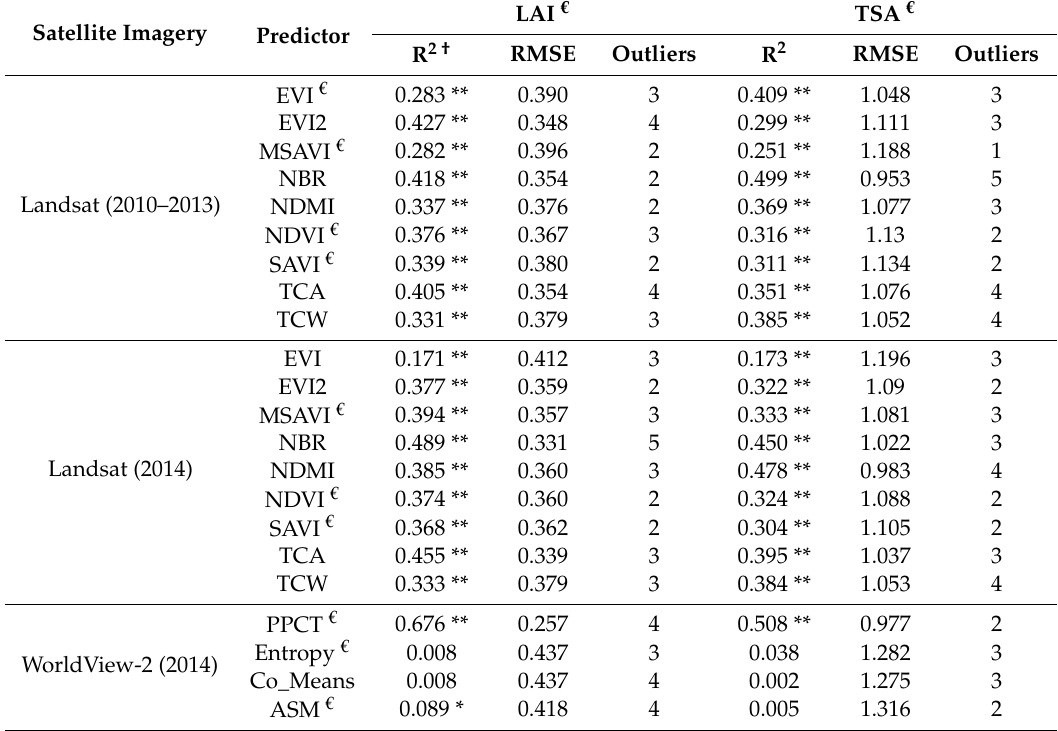
Table 5. Coefficients of linear regression models for evaluating relationships between remotely sensed variables and leaf area index (LAI) and tree sapling abundance (TSA). Landsat-derived spectral index abbreviations see footnote of Table 2. PPCT—Pixel Percentage of Canopy Tree; Co_Means—Means of Co-occurrence Texture; ASM—Angular Second Moment. RMSE—Root Mean Square Error. Satellite